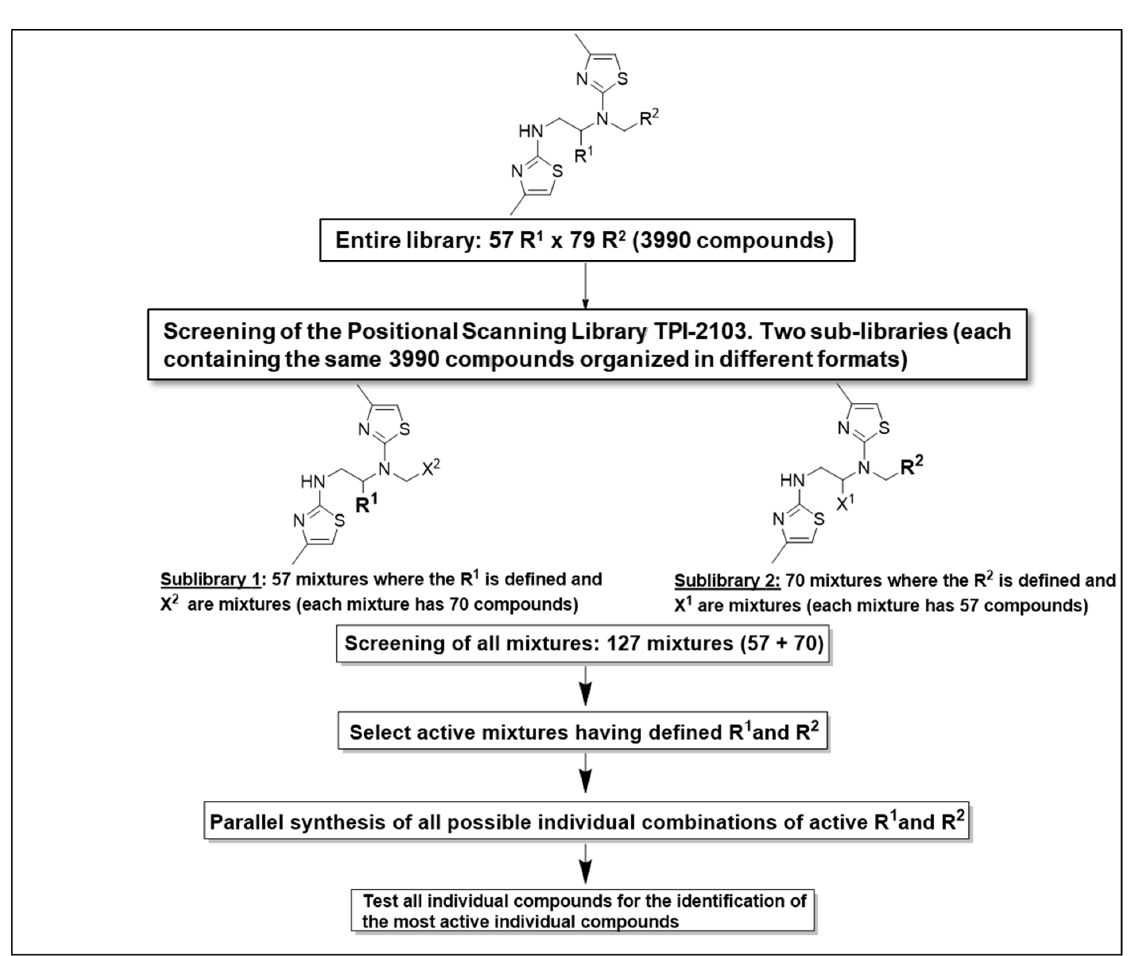
Figure 2. Deconvolution of the positional scan dithiazole library TPI-2103 and synthesis of individual compounds for the identification of the most active hits.